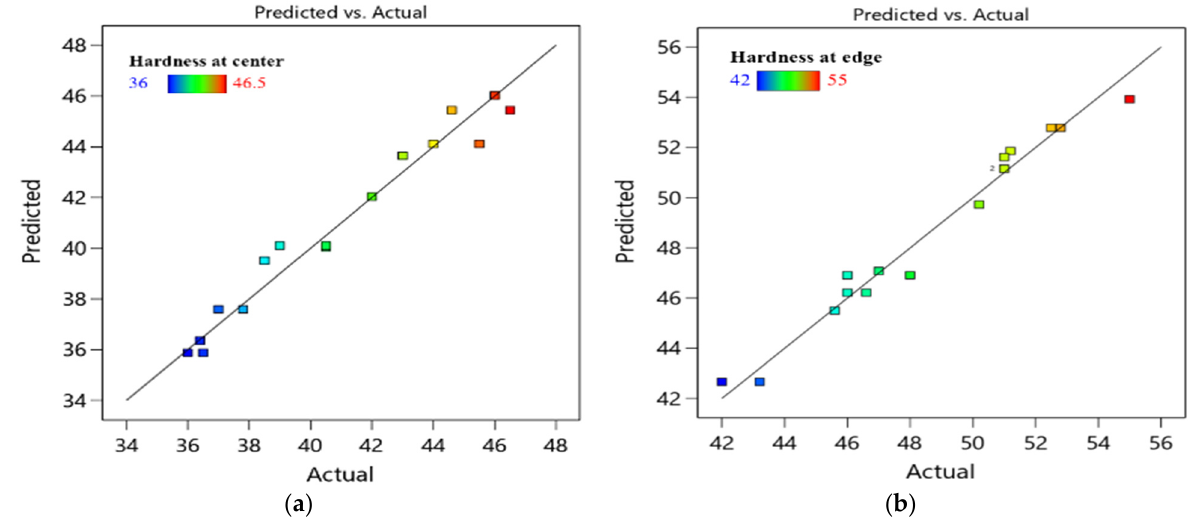
Figure 7. Predicted and actual value of ECAP responses H C ( a ), H E ( b ).